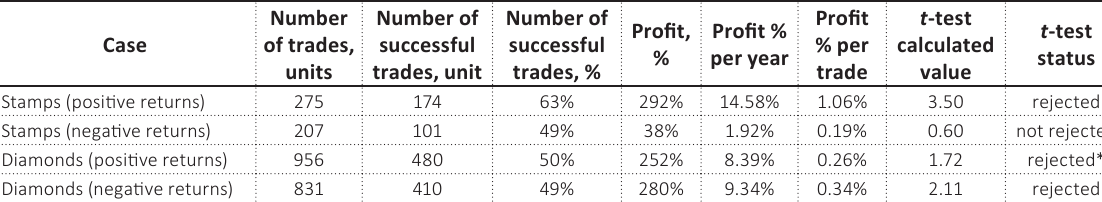
Table 1. Results of a trading strategy based on detected price patterns